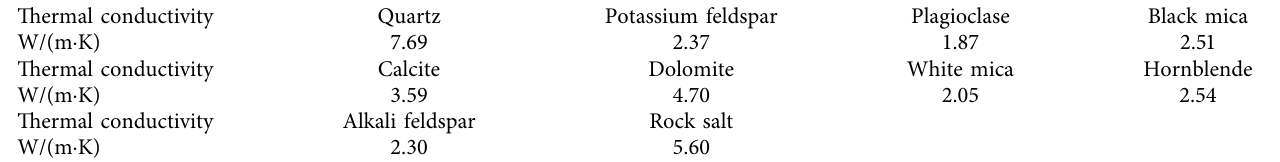
Table 2: Thermal conductivity of different mineral compositions.